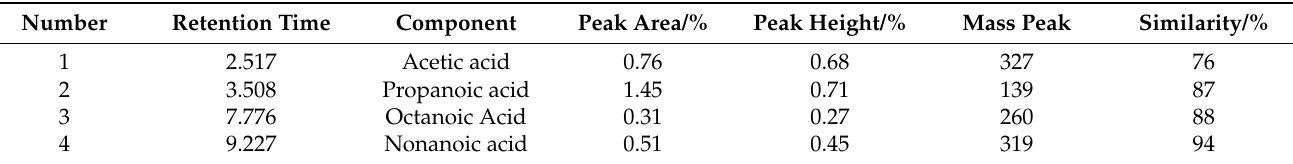
Table 6. Analysis of methanol extract for treated sample